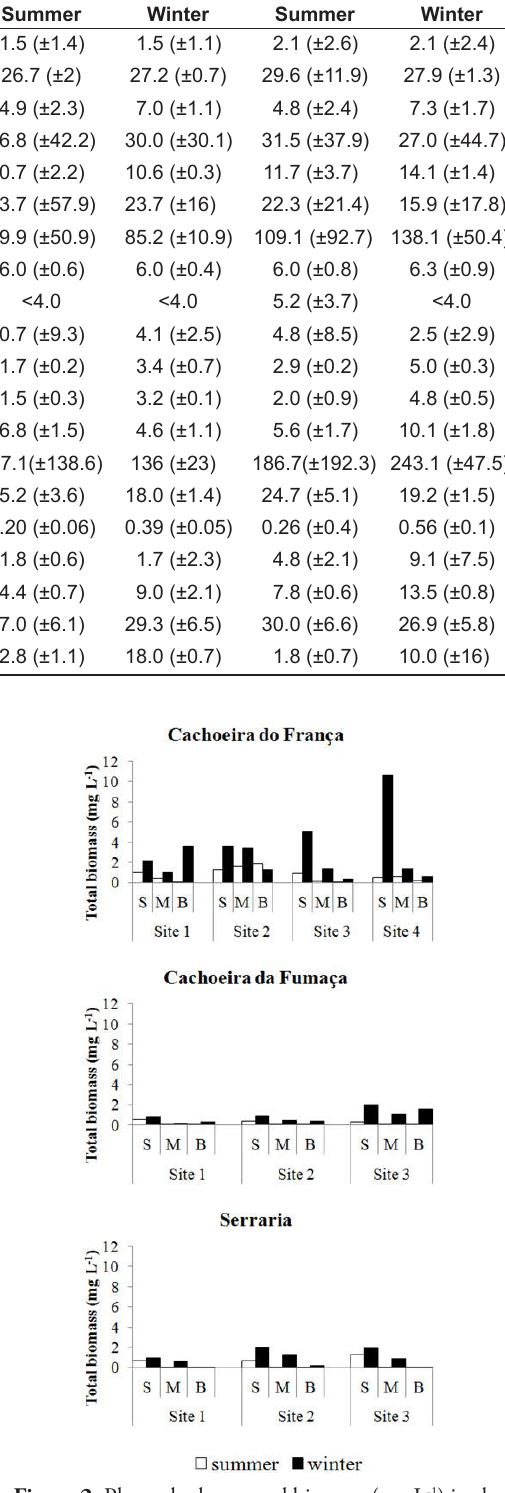
Table 2. Mean values of limnological variables and the standard deviation, in parenthesis, in Cachoeira do França, Cachoeira da Fumaça and Serraria reservoirs during summer and winter. Modified from Marquardt et al. (2018).